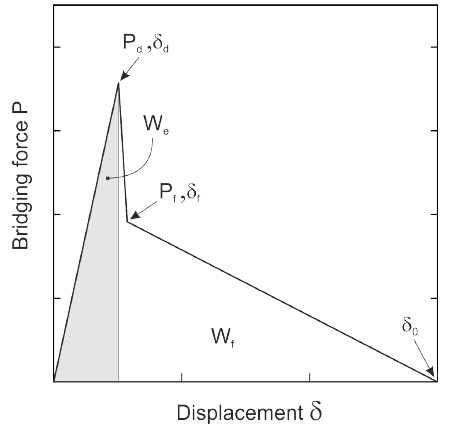
Figure 1. Characteristic trilinear load-displacement relationship during z-pin pullout